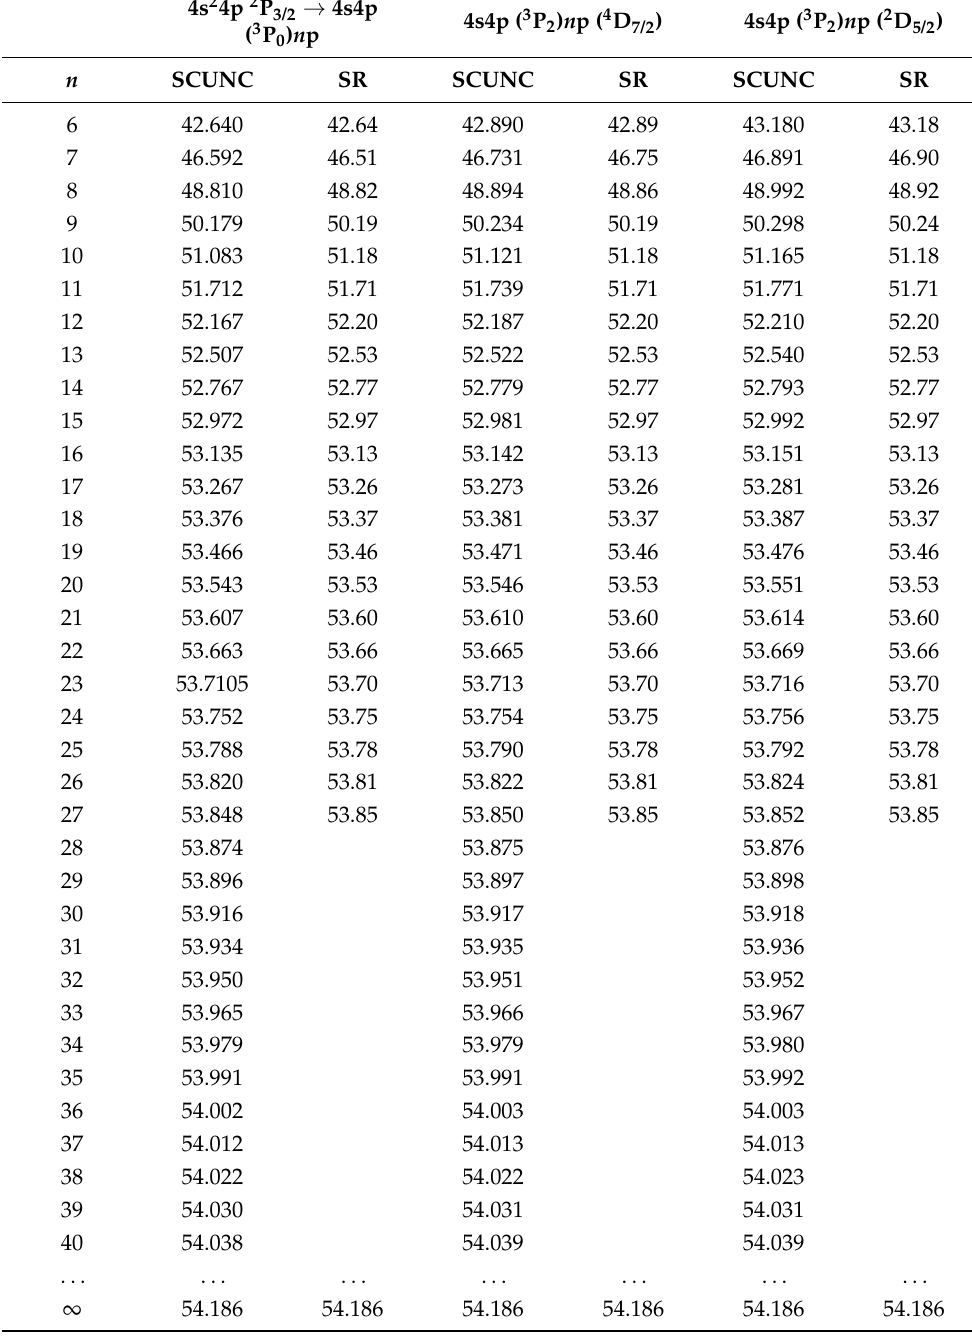
Table 3. Resonance energies (in eV) of the 4s4p ( 3 P 2 ) n p ( 2 P 3/2 , 4 D 7/2 , 4 D 5/2 ) Rydberg series origi- nating from the 4s 2 4p 2 P 3/2 states of Se 3+ converging to the 3 P 2 series limit in Se 4+ . The SCUNC results are compared to the SR data of Esteves et al. [22]. The screening constants are equal to: f